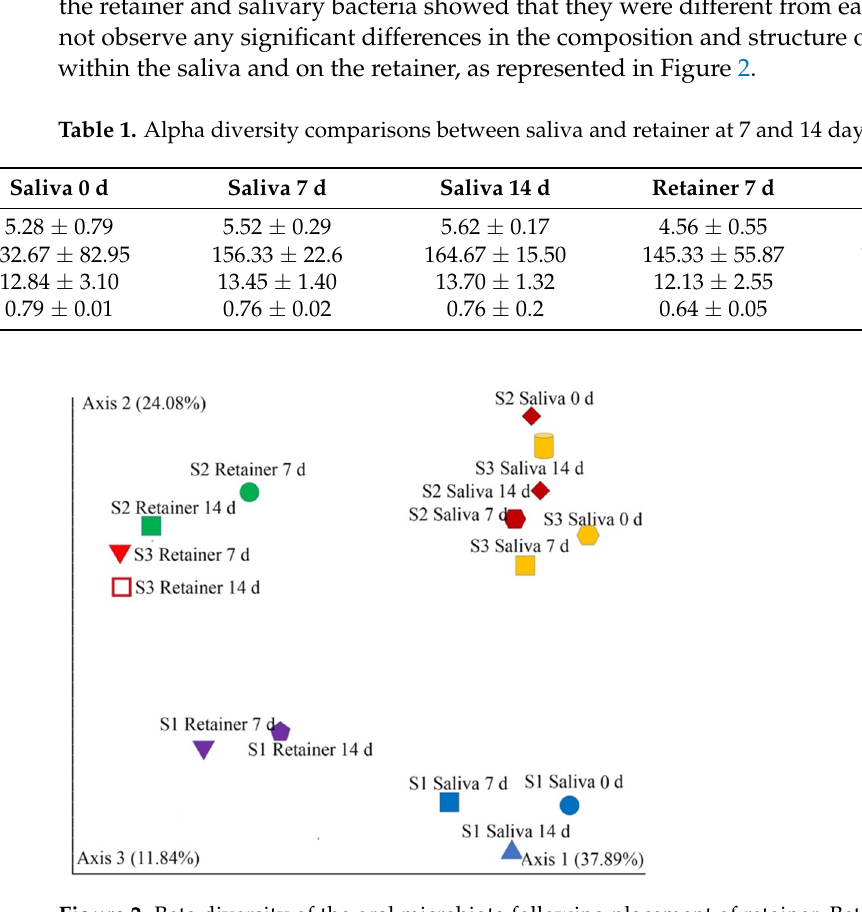
Figure 2. Beta diversity of the oral microbiota following placement of retainer. Beta diversity Jaccard index, based on Principal Coordinates Analysis (PCoA) of all samples. There were no significant differences in the composition and structure of oral flora between the saliva and retainer. The sample spread was statistically different based on Permutational Analysis of Variance (PERMANOVA) ( p < 0.05). The saliva groups are clustered in the right part of the main horizontal axis. The retainer group is clustered in the left part of the main horizontal axis. Abbreviations: round, saliva 7 d; cylinder, saliva 14 d; cone, retainer 7 d; diamond, retainer 14 d.